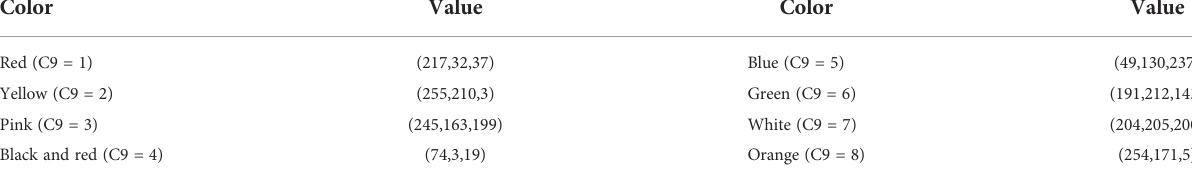
TABLE 3 Chinese roses ’ color